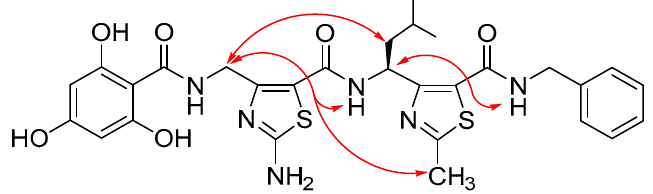
Figure 4. Characteristic nuclear overhauser effect (NOE) correlations observed for typical constrained γ -peptidic dimer 10c. γ -peptidic dimer 10c.